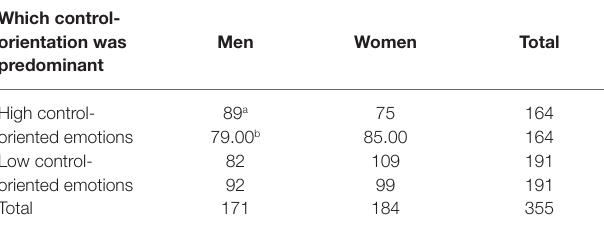
TABLE 3 | Frequency table of selected emotion’s control orientation for women and men—Raw data. Which control- orientation